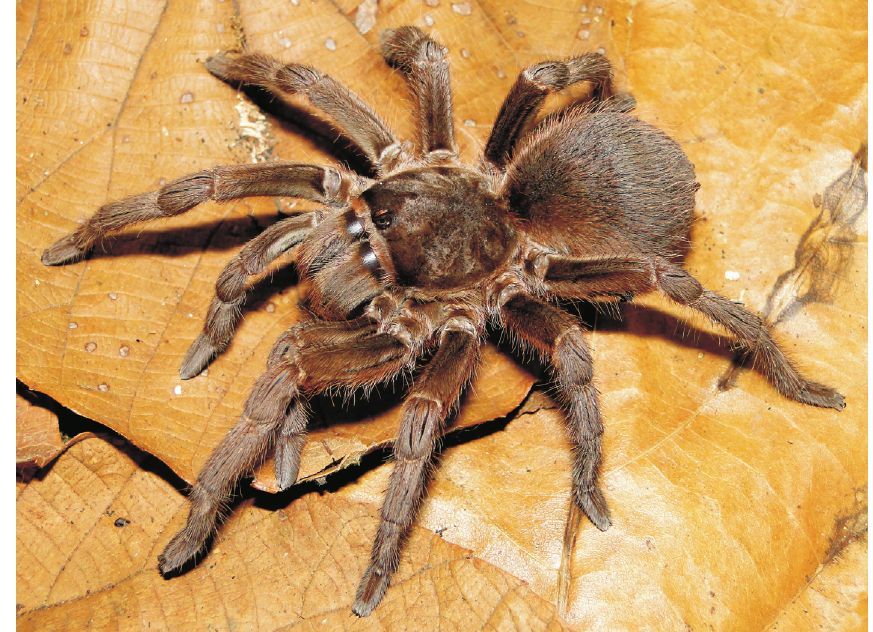
Figure 9. Acanthoscurria natalensis (IBSP 109238), female from Lajeado, state of Tocantins, dorsal view. Photo: Rafael P.